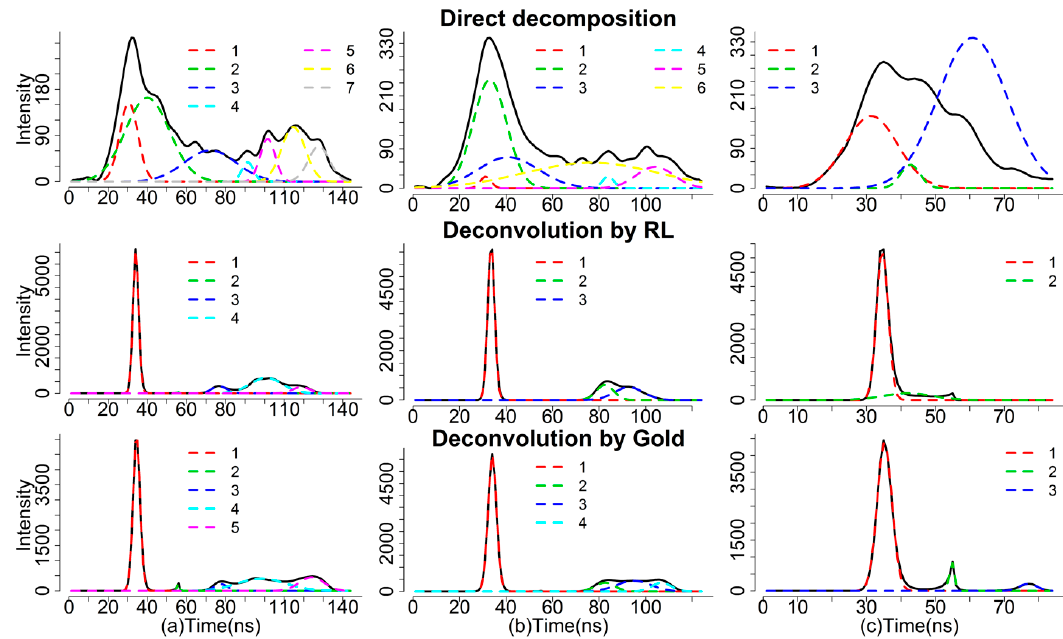
Figure 4. Comparisons of the decomposition results with the direct decomposition approach, Richard-Lucy (RL) approach and Gold approach for three sample pulses ( a – c ). The solid black line is the original waveform. The colored dash lines are Gaussian components after decomposition [6] .